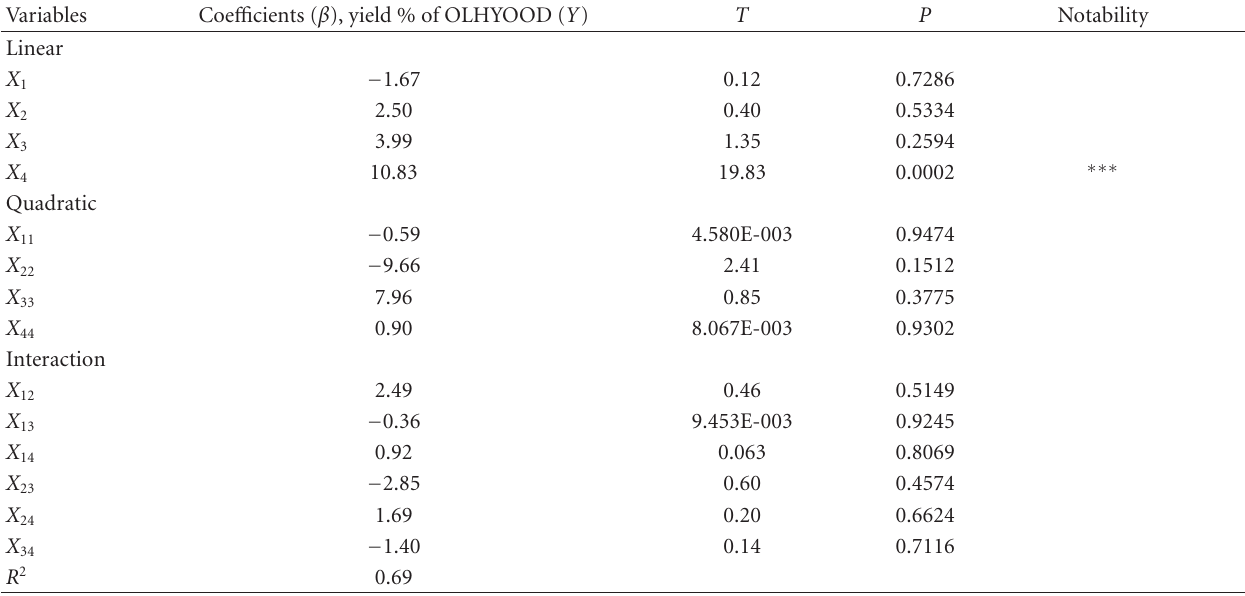
Table 3: Regression coe ffi cients of the predicted quadratic polynomial model for response variables of the yield % of OLHYOOD. Variables